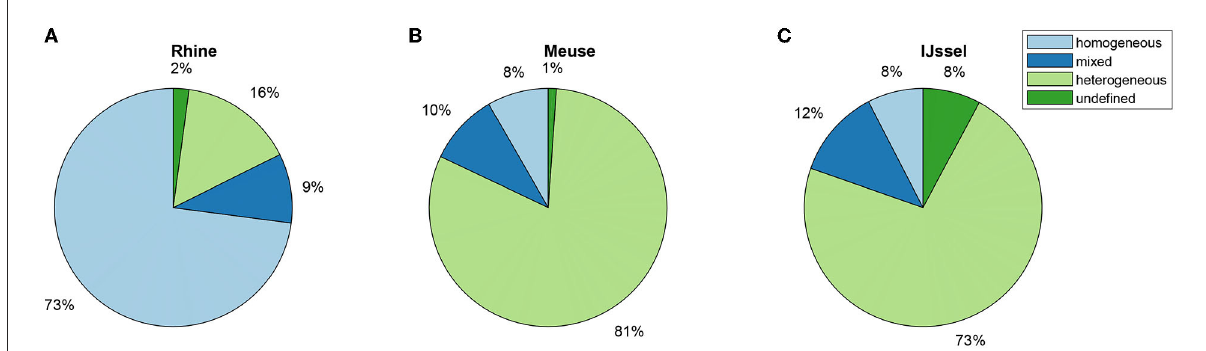
FIGURE6 River system heterogeneity based on a 90% confidence boundary and 10% deviation from the mean, in the river Rhine (R1, R2, R3) (A) , Meuse (M1, M2, M3) (B) , and IJssel (IJ1, IJ2) (C) . Homogeneous: SSR category ≤ median SSR all (40 items). Heterogeneous; SSR category ≥ mean SSR all (158 items). Mixed: median SSR all < SSR category < mean SSR all . Undefined: SSR could not be determined.